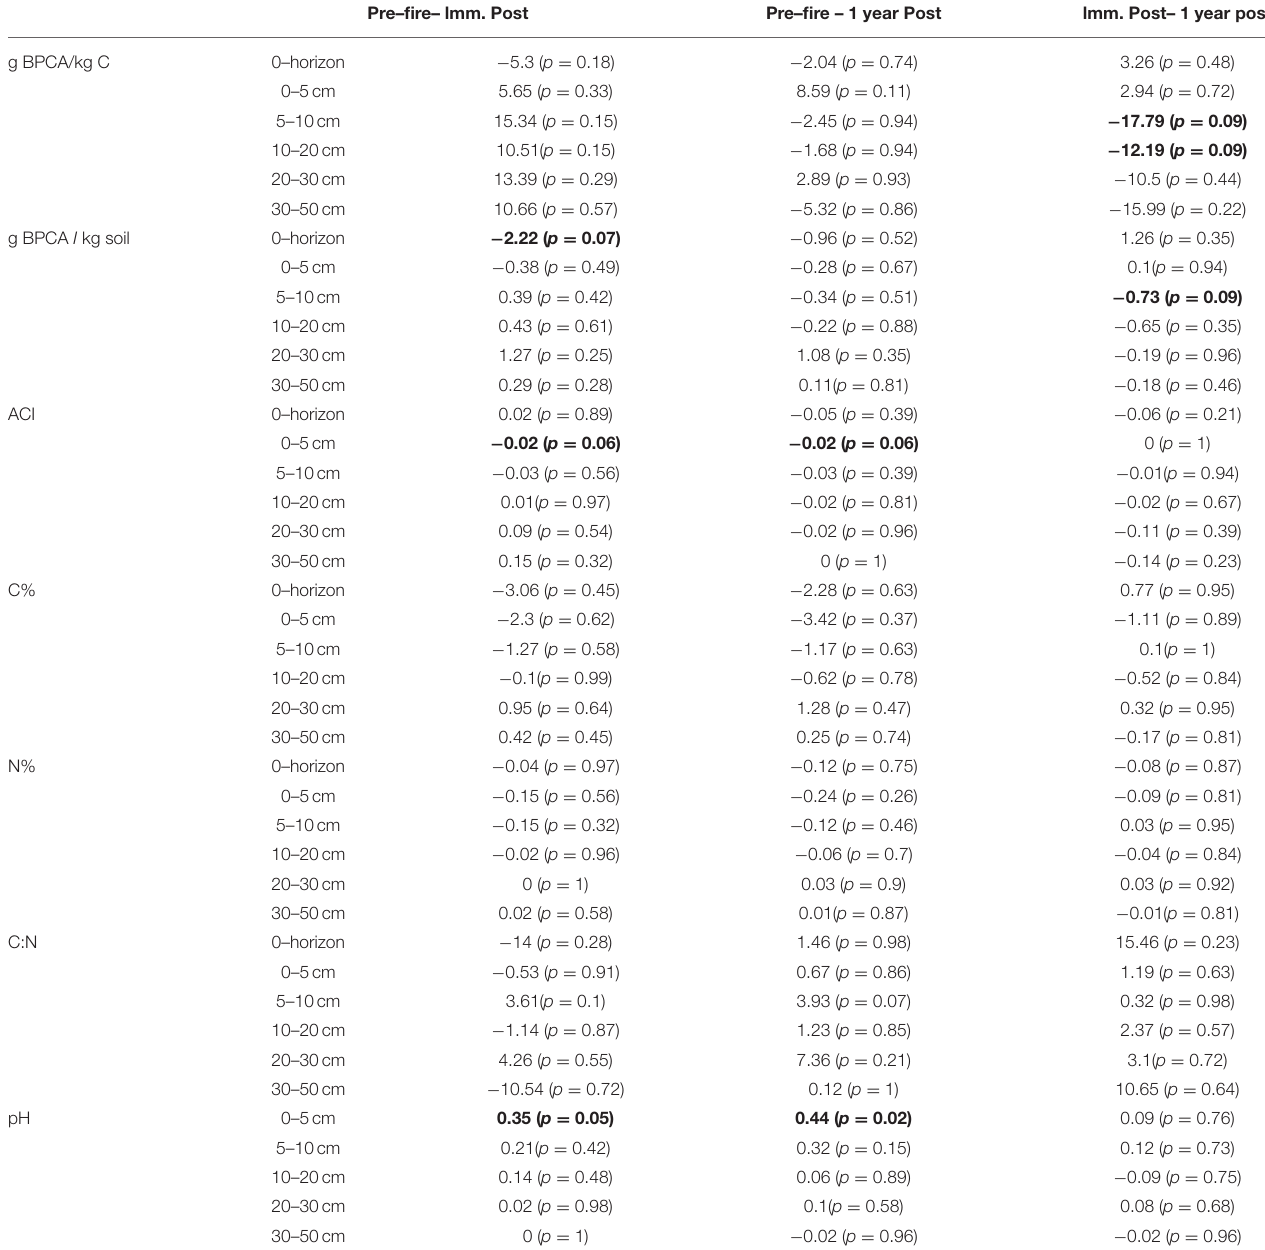
TABLE 1 | Differences in response variables at different time points for core samples collected from the soil array plots that burned at low severity during the Chimney Tops 2 fire. Pre–fire– lmm.